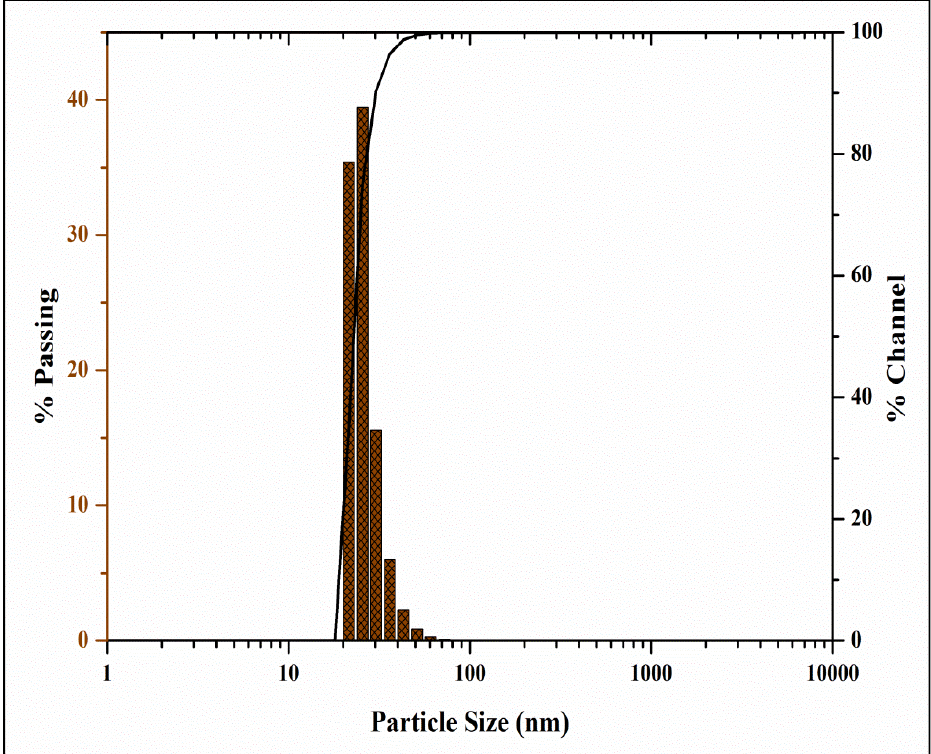
Figure 3. Dynamic Light Scattering Analysis of phyto-fabricated ZnO-NPs from I. obscura aqueous leaf extract.